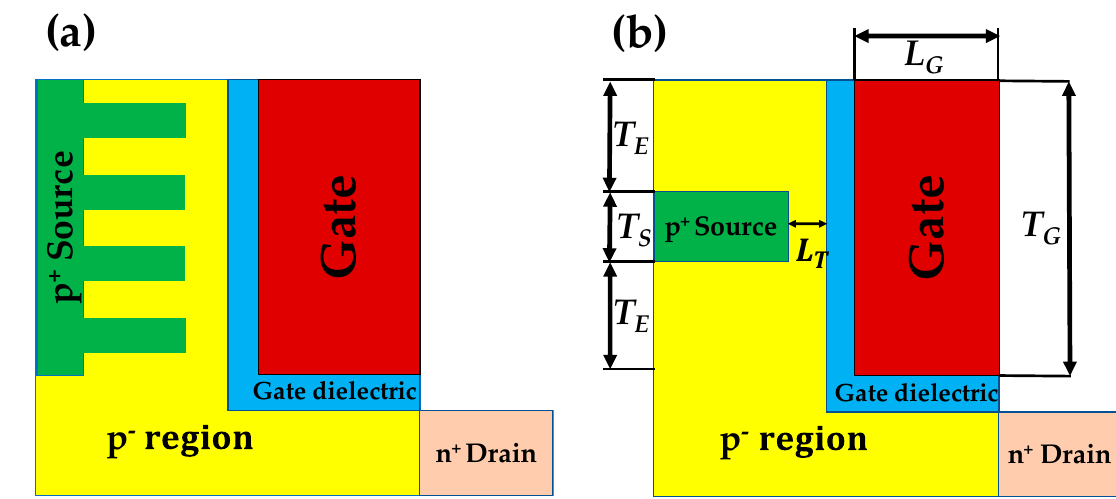
Figure 1. ( a ) Structure of the F-shaped tunnel field-effect transistor (TFET) with multiple sources. ( b ) Structure and parameter definitions of the F-shaped TFET. Table 1. Parameters used for the technology computer-aided design (TCAD) simulation.